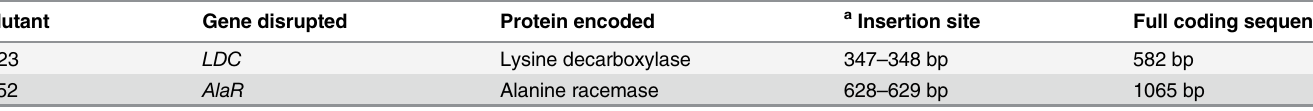
Table 1. Genes disrupted by Tn5 transposon DNA in cellulose morphology